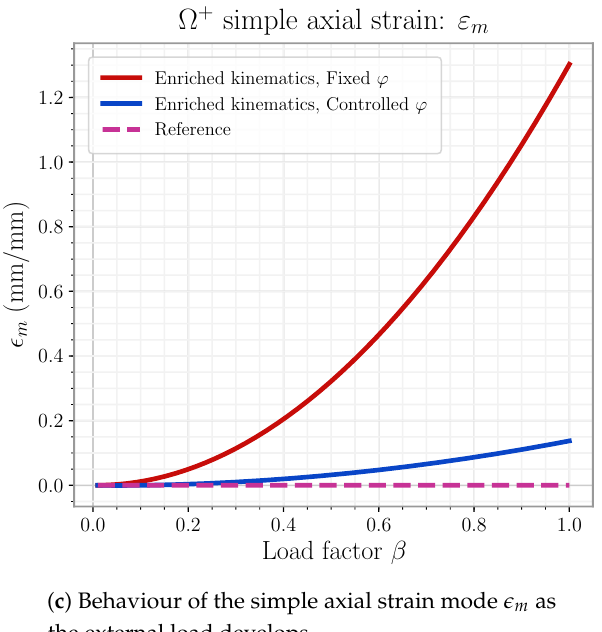
Figure 19. Comparison of the response of the simple axial strain modes associated with the Ω + body partition: ( a ) axial strain (cid:101) n , ( b ) axial strain (cid:101) t and ( c ) axial strain (cid:101) m . Only for enriched mode